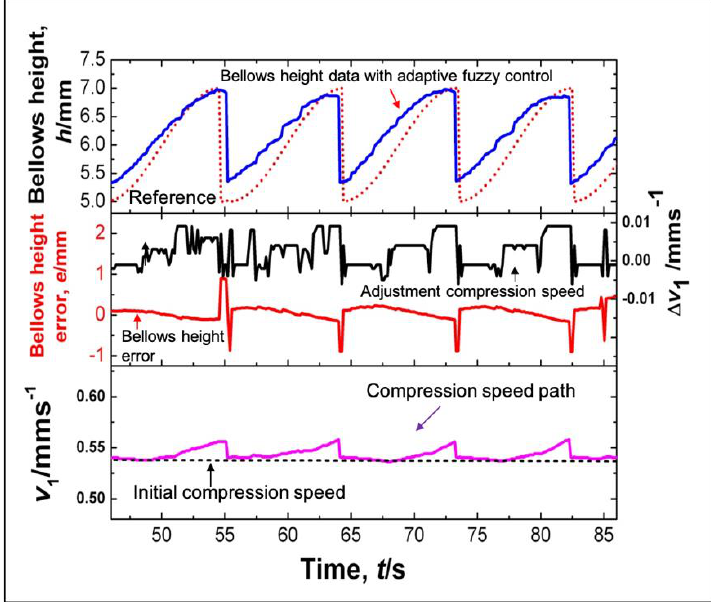
Figure 17. Bellows profile produced using an adaptive fuzzy control.